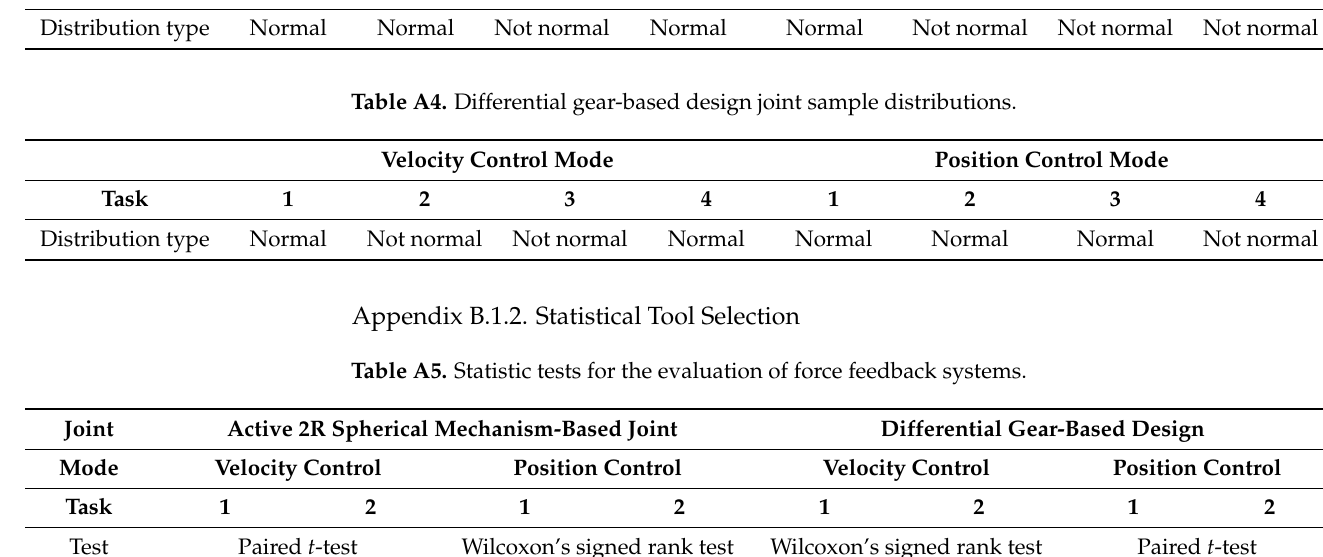
Table A6. Tests for control mode assessments.